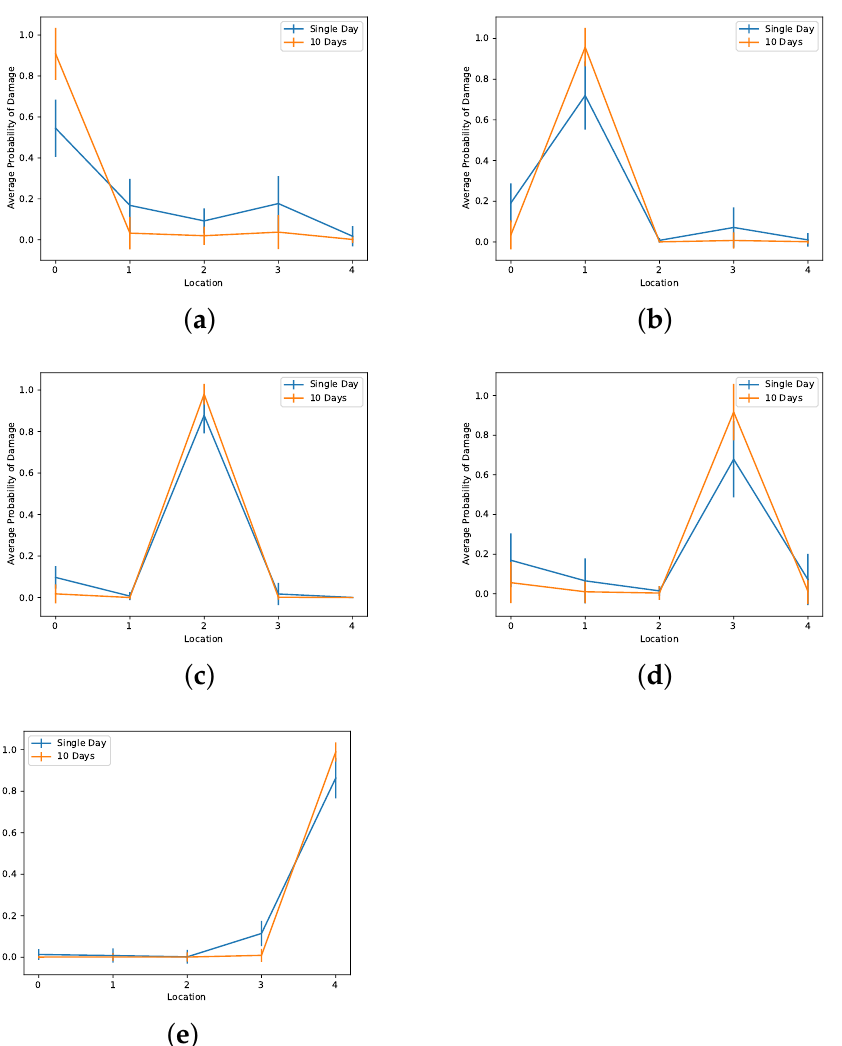
Figure 15. Average probability of damage obtained after training a network with five classes; mea- surements without damage ( a ) and measurements with damage at four locations ( b – e ) corresponding to locations 1 to 4 respectively. Location 0 means no damage. In general, we detect the location of the damage with a higher probability when we use multiple-day measurements instead of single-day measurements. Five natural modes are monitored.